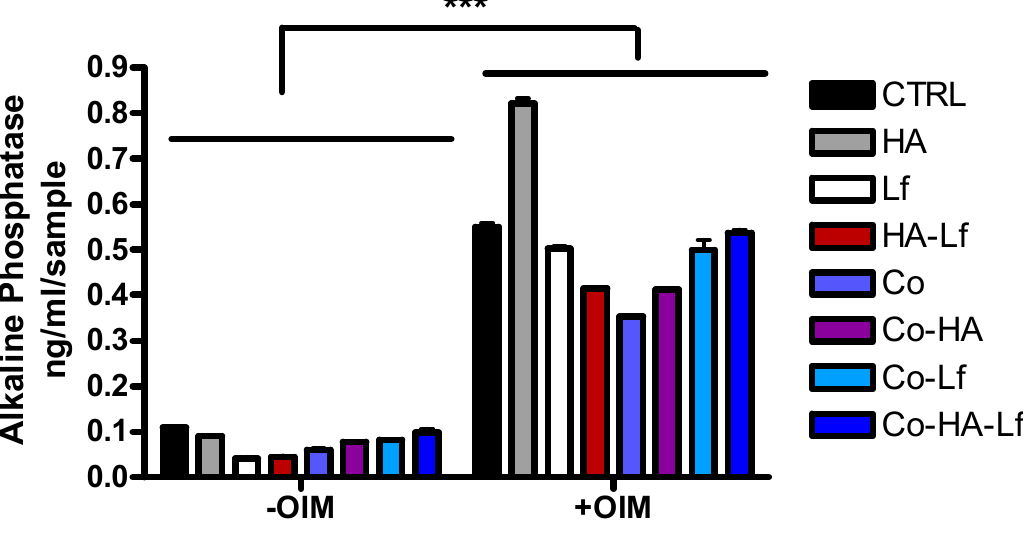
Figure 9. Differentiation of hMSCs to osteoblasts on different surfaces. Quantification of ALP activity at 14 days of hMSCs cultivation with and without osteogenic factors. Data analysis was based on mean ± SD (n = 3). The significance level between groups was *** p < 0.001.